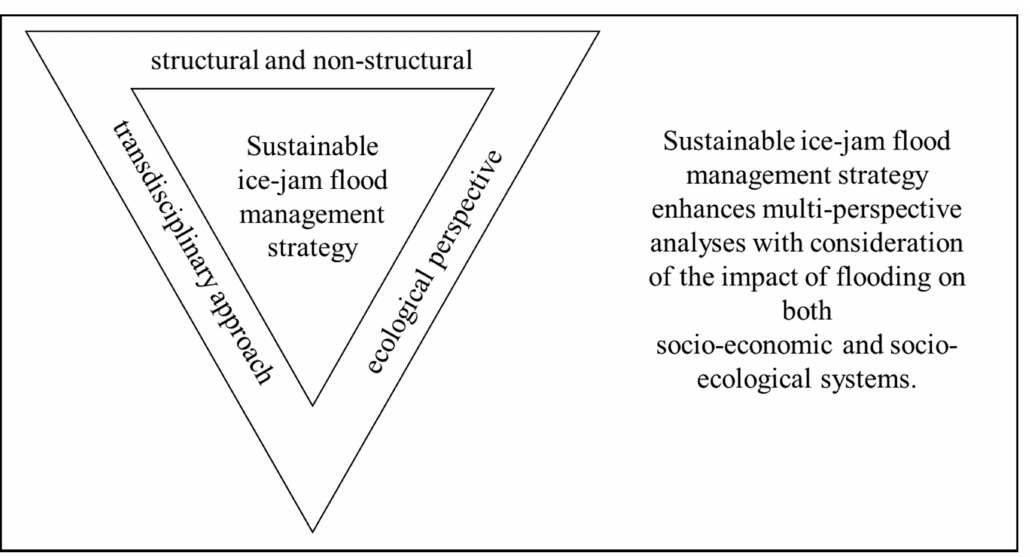
Figure 1. The summary of the sustainable ice-jam flood management